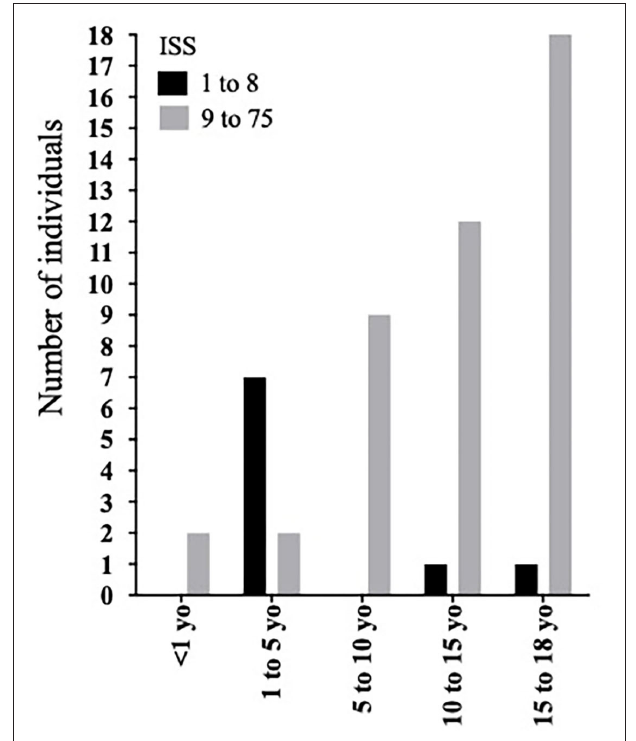
FIGURE 2 | Overtriage distribution in different age groups according to ISS < 9 as a cutoff.